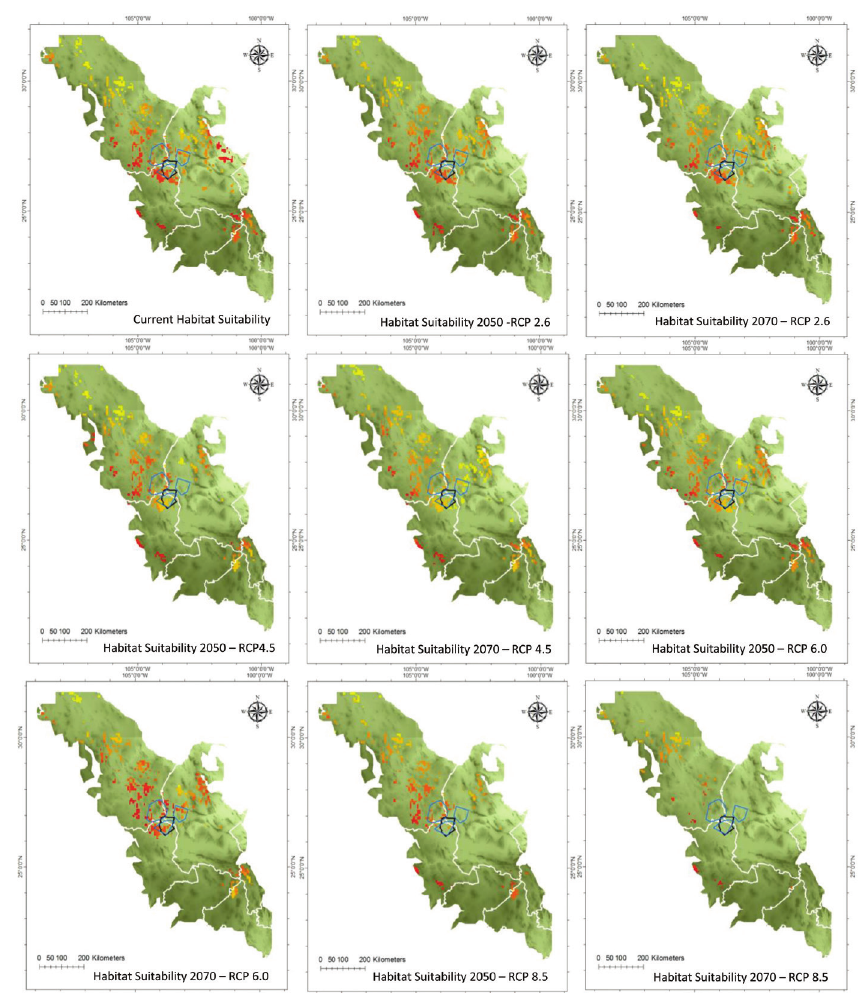
Figure 3. Habitat suitability models of the halophytic grasslands projected for Chihuahuan Desert. White lines show states boundaries; black lines refer to the Mapimí Biosphere Reserve; blue lines indicate distribution zones of G. flavomarginatus